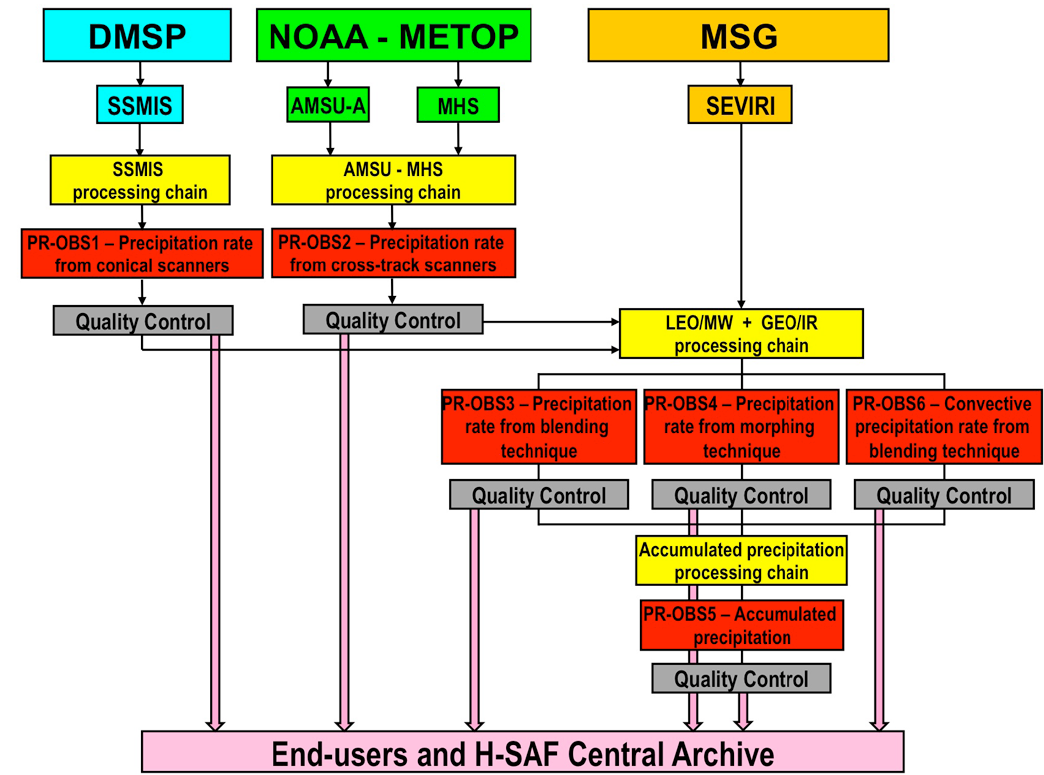
Fig. 9. Flow diagram of the H-SAF precipitation product generating